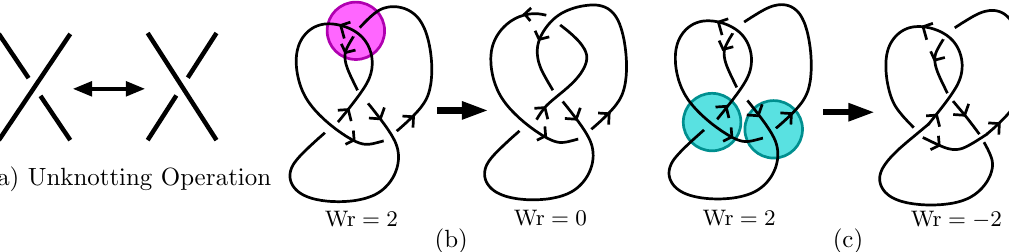
Fig. 5. We cannot change the randomly selected crossings to obtain a required knot type. (a) The unknotting operation. (b) The unknotting operation at the top crossing leads to a non-trivial knot. (c) The uknotting operations at the bottom crossings keep decreasing the writhe and keep the triviality of γ